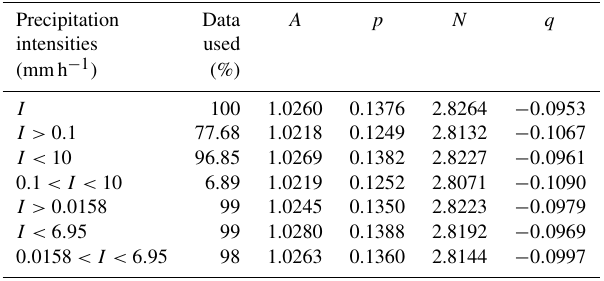
Table 4. Sensitivity of constants to the selected